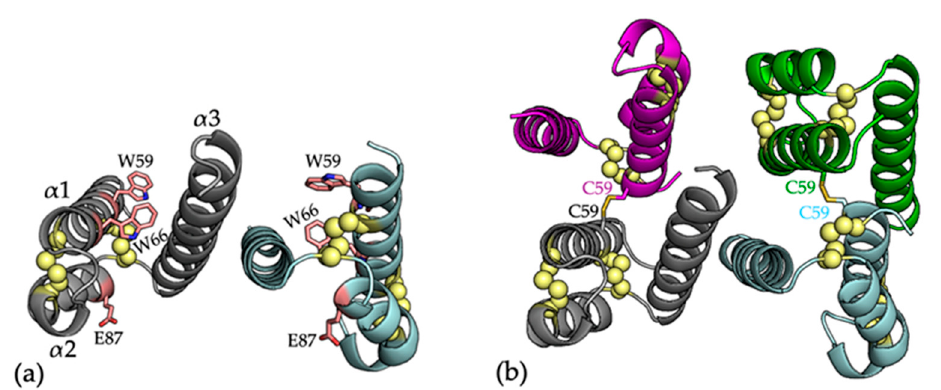
Figure 3. ( a ) The crystal structure of COA6, with residues that are mutated in patient samples shown as pink sticks (PDB 6PCE) [56]. Secondary structures are represented as cartoons with monomers colored in cyan and gray. Cysteine residues are shown as yellow spheres; ( b ) Cartoon representation of the crystal structure W59C COA6 (PDB 6PCF) [56]. Individual protomers are colored in cyan, gray, purple, and green. Each monomer (cyan and gray) is linked to another monomer (green and purple, respectively) by an intermolecular disulfide bond (shown as yellow sticks) through the introduced Cys59 residue.